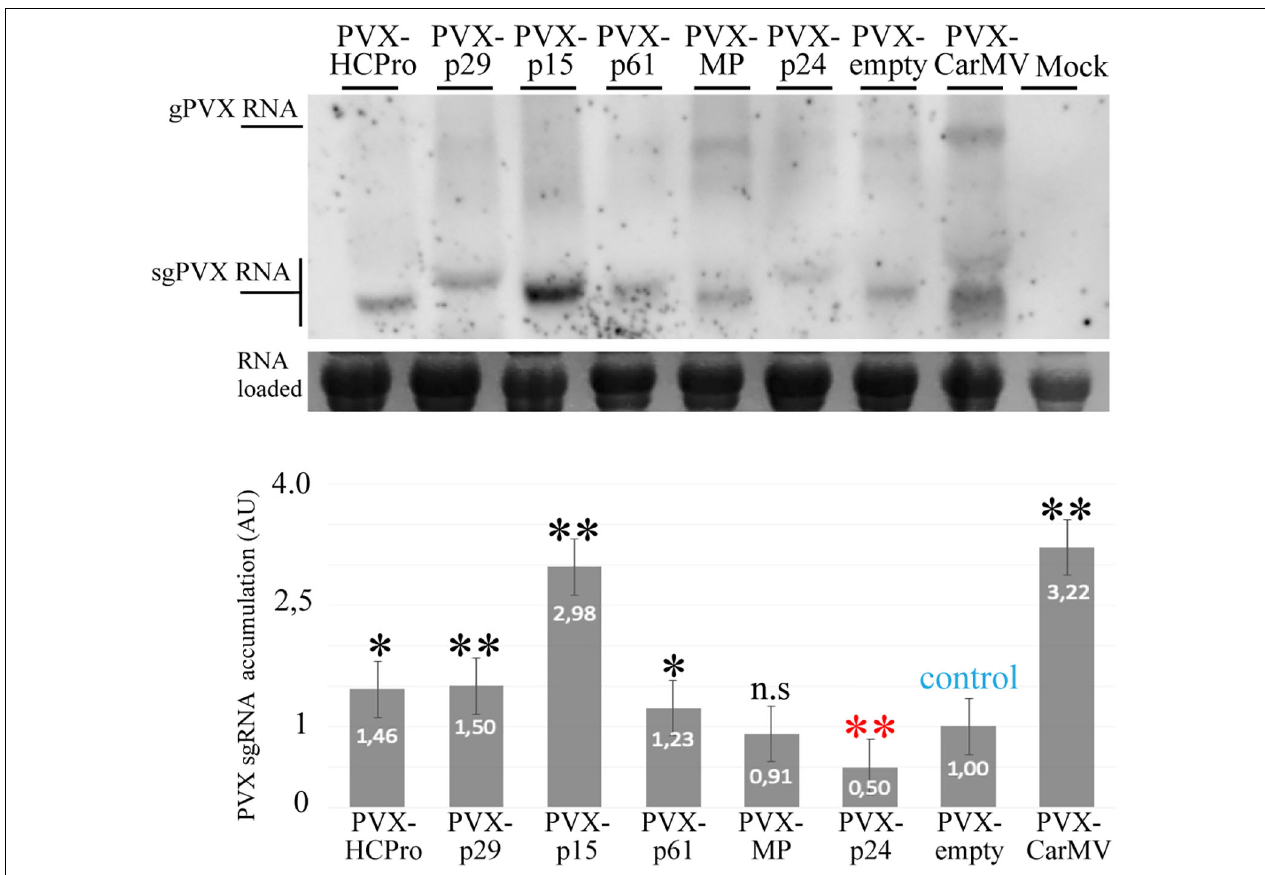
FIGURE 6 | The p29, p15, and p61 expression increase the PVX accumulation. Northern blot analysis showing accumulation of the subgenomic (sgPVX) PVX RNAs using a dig-riboprobe complementary to the 3’ end region of the PVX CP gene at 4 dpi. rRNA stained with ethidium bromide indicates equal loading of samples. Mock corresponds to uninfected plant. The graph represents the relative sgPVX RNA accumulation. The values correspond to the averages of three different experiments in which the data are normalized to the negative control (PVX-empty). The bands were quantified using ImageJ version 2.0cr software with ISAC plugin and error bars represent standard deviation. Statistical analysis were done using Student’s t -test. Black asterisks ( ∗ ) indicate significantly increased viral accumulation compared to the control, while red asterisks ( ∗ ) indicate significatively decreased viral accumulation. ∗∗ , p < 0.01; ∗ , p < 0.05; n.s, no significant difference. P -values were obtained from pairwise comparations between control vs. viral